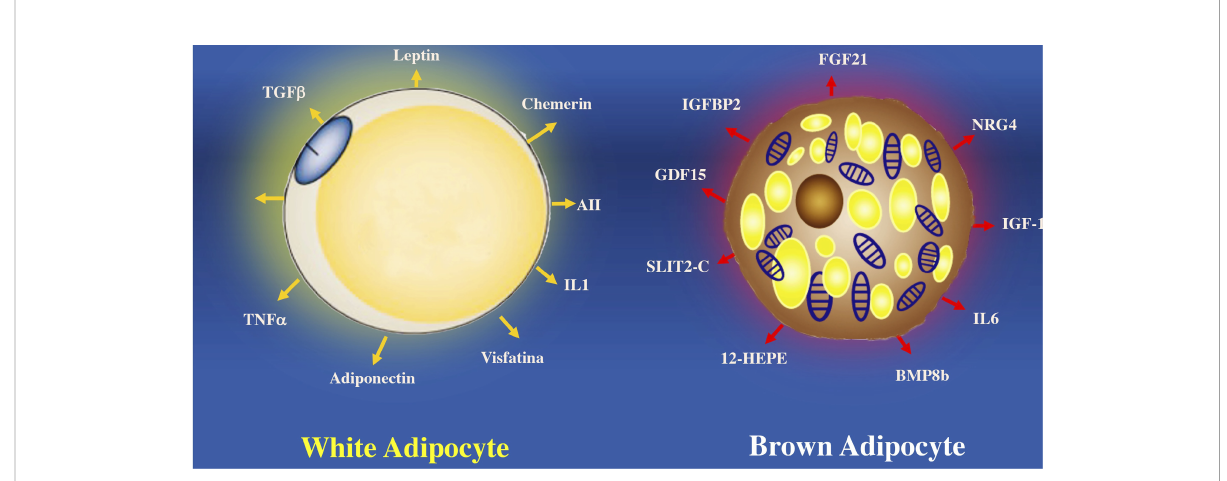
FIGURE 4 Estradiol availability affects the regulation of enzymes involved in glycolysis in the cytoplasm and in the tricarboxylic acid cycle (TCA) in mitochondria. Estrogens increase the activity of some glycolysis enzymes listed in the fi gure (hexokinase, phosphofructokinase, enolase, pyruvate kinase). E 2 improves the glycolytic – pyruvate – acetyl-CoA pathway to generate the electrons necessary for oxidative phosphorylation and thus the generation of ATP to maintain the use of glucose as a primary source of